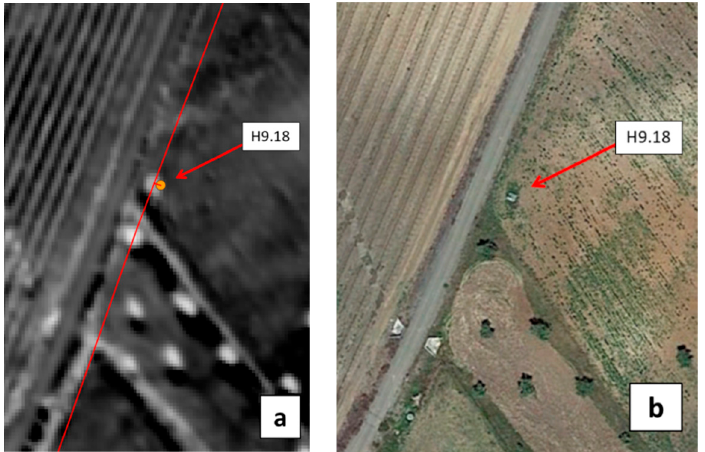
Figure 24. ( a ) WI image showing hydrant H9.18 as obtained with the MAV (excerpt from Figure 22a). ( b ) Google Earth image of the same area.